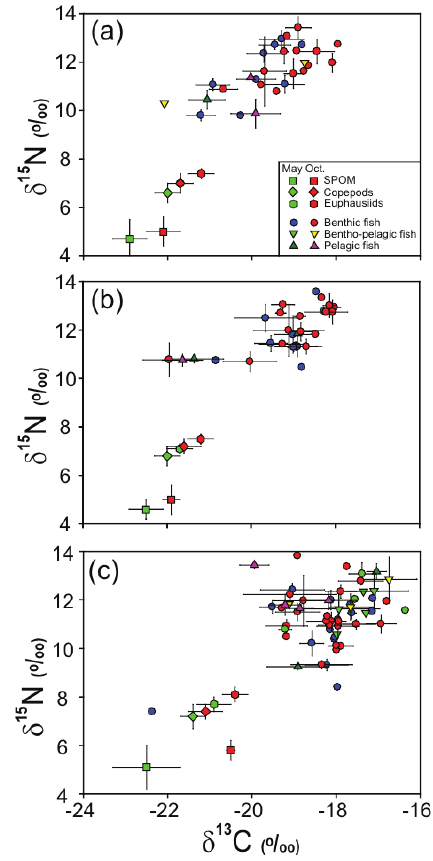
Figure 2. Dual isotope plots of δ 13 C and δ 15 N values of zooplankton and fish consumers and their potential food sources (suspended particulate organic matter, SPOM) at the sampling sites (( a ), St. A; ( b ), St. B; ( c ), St. C) in May and October. Values are presented as mean δ 13 C and δ 15 N ( ‰ ± 1 SD).